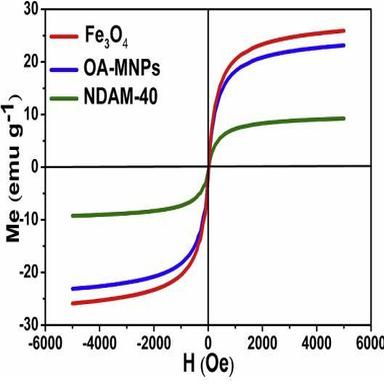
Magnetic hysteresis loops of Fe3O4, OA-MNPs, and NDAM-40.